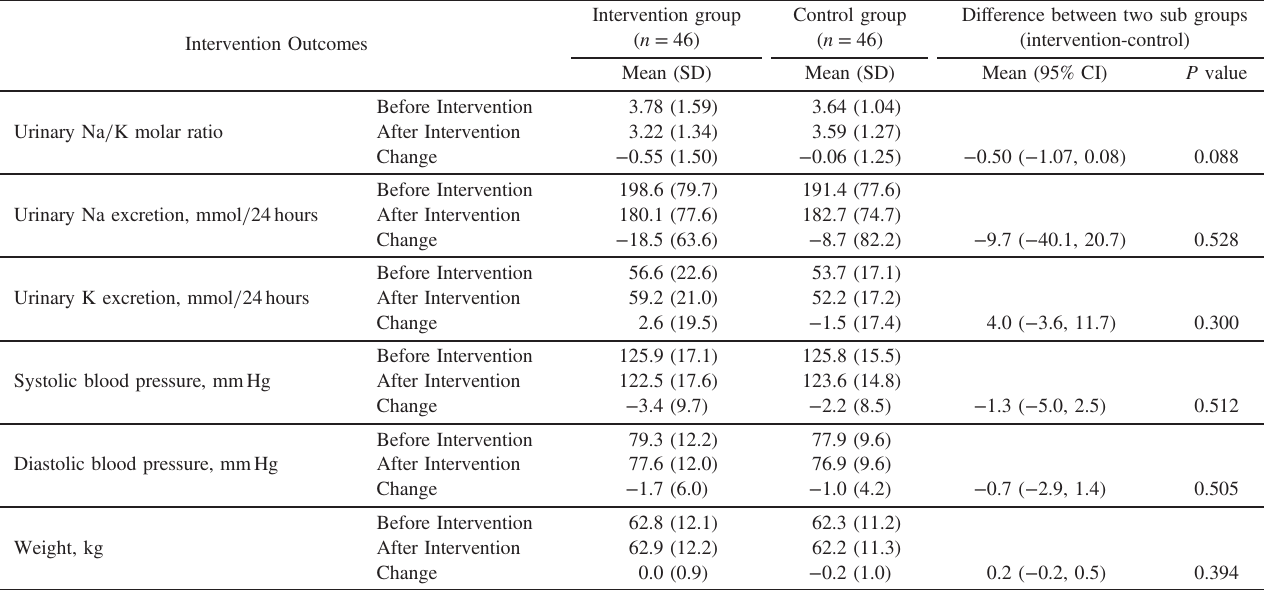
Table 2. Intervention outcomes at baseline and 1-month outcome assessments Intervention group Control group Di ff erence between two sub Intervention Outcomes